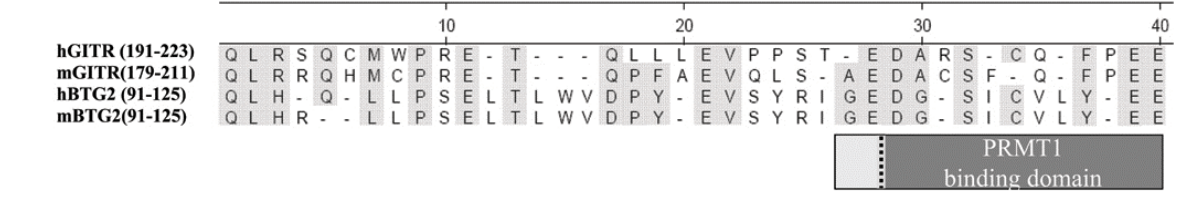
FIGURE 7 . Homology beetween BTG2 e